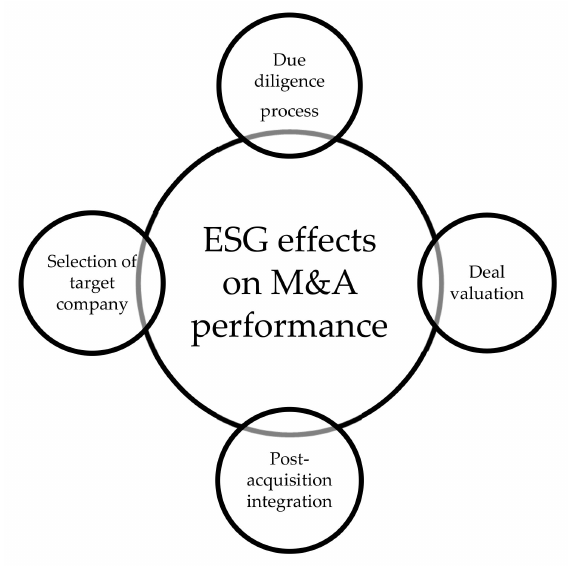
Figure 2. Framework for assessing environmental, social and governance (ESG) issues during M&A